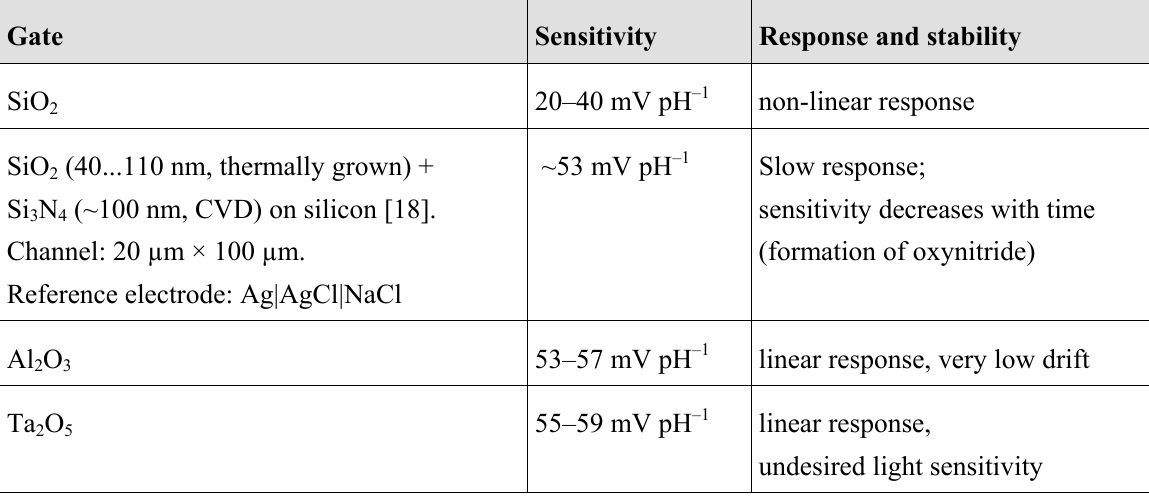
Table 1. Properties of ISFET pH-sensors with different gate materials [17].